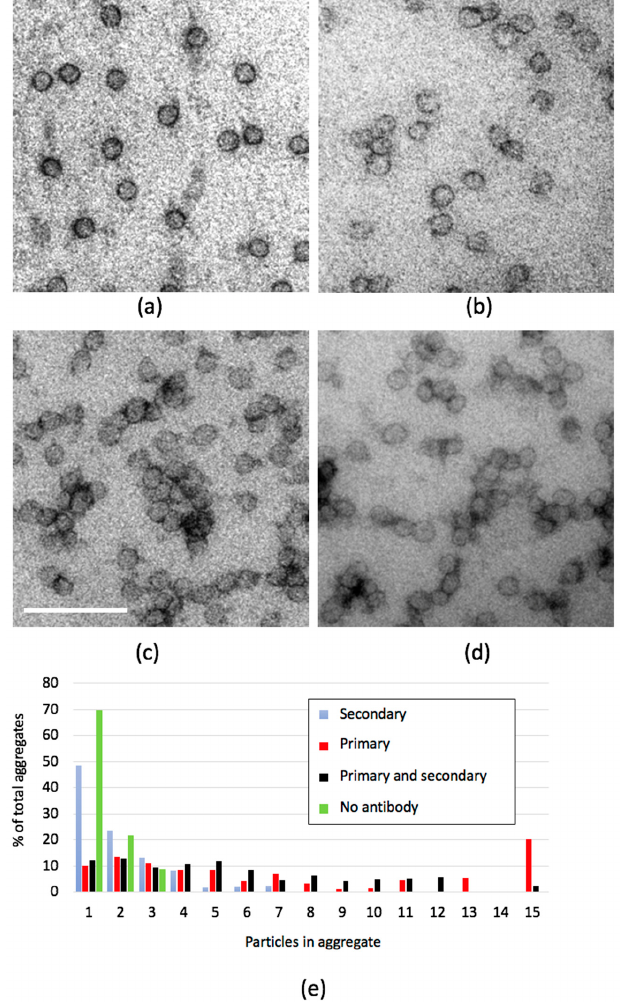
Figure 4. Antibody-induced aggregation of LDL on electron microscopy (EM) support films. This strategy, an alternative to direct contrasting, aims at detecting antigens by crosslinking particles with specific antibodies in an approach that is akin to hemagglutination. LDL particles were adsorbed to the support film and exposed to anti-ApoB polyclonal antibodies. ( a ) No antibody, ( b ) secondary antibody alone, ( c ) primary antibody, and ( d ) primary followed by secondary antibody. Notice aggregation of LDL appears similar in extent in ( c ) and ( d ). Scale bar in (c) 50nm, for (a-d). ( e ) Quantification of the aggregation under same conditions as illustrated in ( a–d ). Distributions for control (no-antibody) and secondary only (secondary) are similar. Both primary alone (primary) and primary plus secondary (primary and secondary) conditions lack single particles and two-particle aggregates and contain more large aggregates. primary vs. secondary, chi square = 64.29, df 3, p < 0.001; primary vs. no antibody, chi square = 53.89, df 3, p < 0.001; no antibody vs secondary, chi square = 1.81, df 3, p < 0.2.